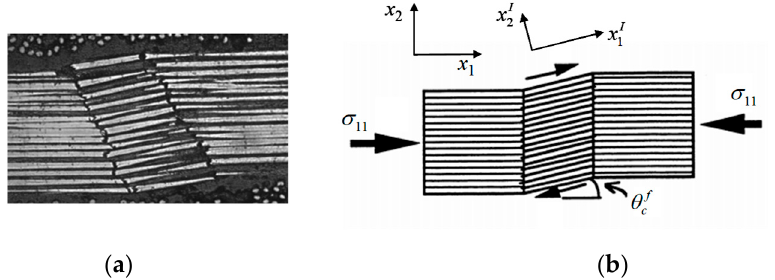
Figure 9. ( a ) Longitudinal compression-induced kink-band failure, ( b ) load analysis in kink band coordinate system.